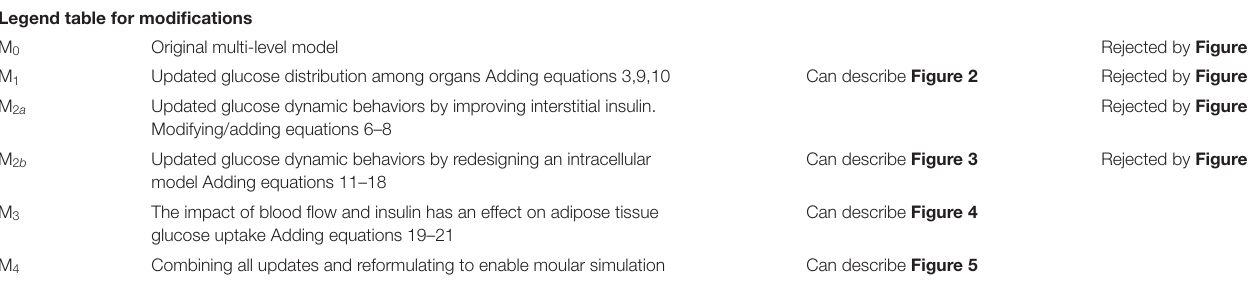
TABLE 1 | Differences between the herein presented models. Legend table for